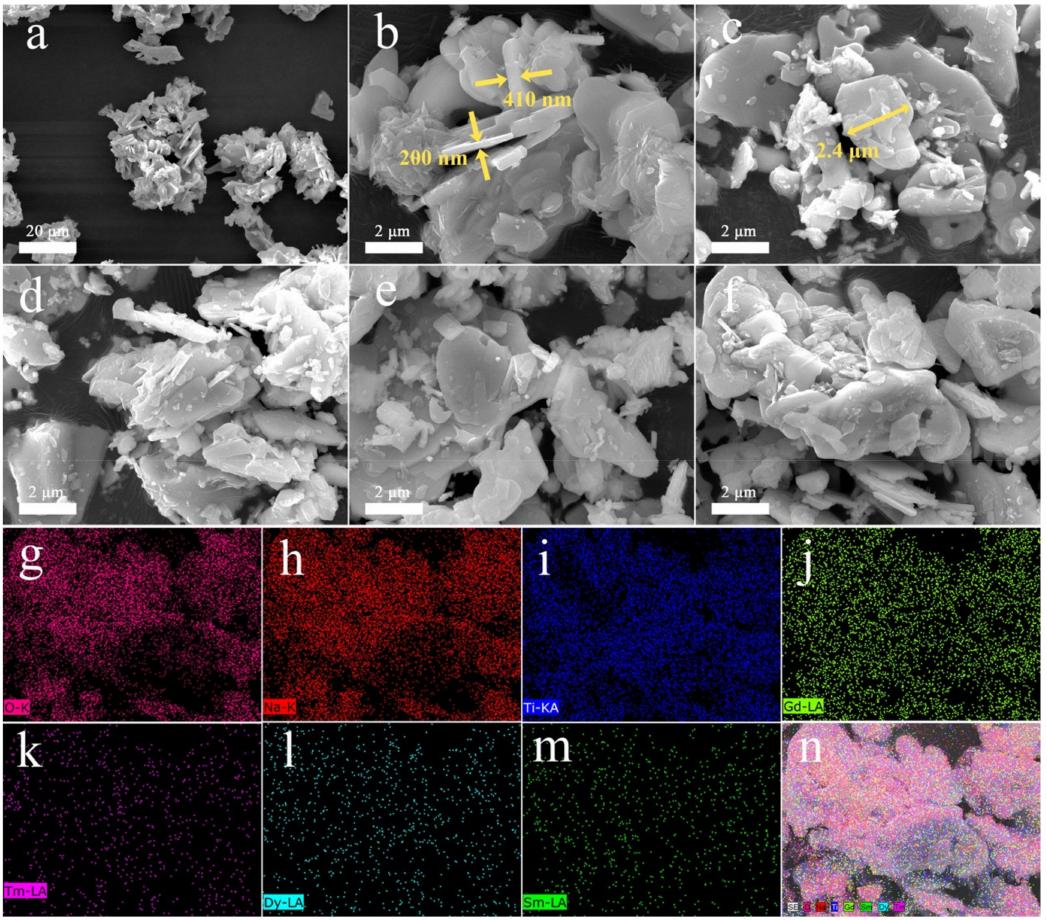
Figure 2. ( a – f ) SEM images of NGT: 3%Tm 3 + , NGT: 5%Dy 3 + , NGT: 3%Sm 3 + , NGT: 3%Tm 3 + / 5%Dy 3 + , NGT: 3%Tm 3 + / 3%Sm 3 + , and NGT: 3%Tm 3 + / 5%Dy 3 + / 3%Sm 3 + ; ( g – n ) EDS mapping results of the NGT: 3%Tm 3 + / 5%Dy 3 + / 3%Sm 3 +